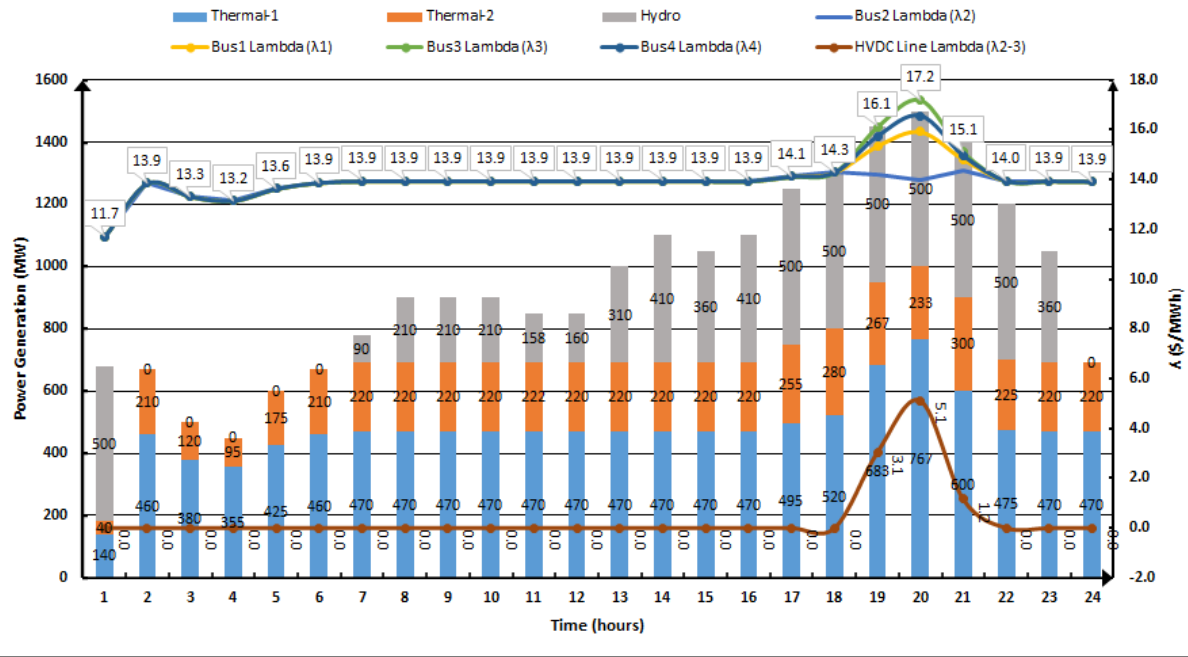
Figure 6. Hydrothermal scheduled power, bus price, and line limit price.